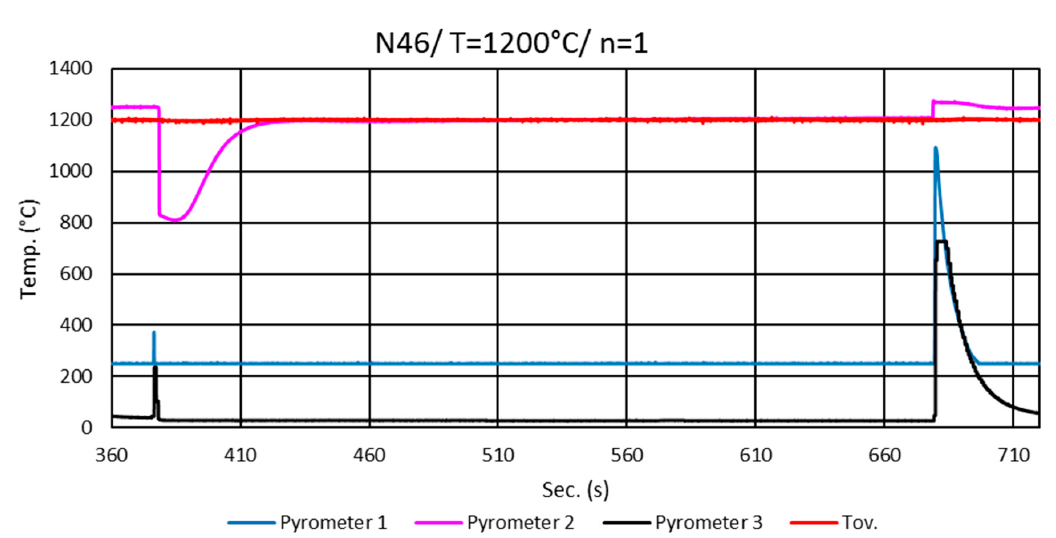
Figure 9. Surface roughness investigations of uncoated and coated Nimonic 80A substrate. Revised.